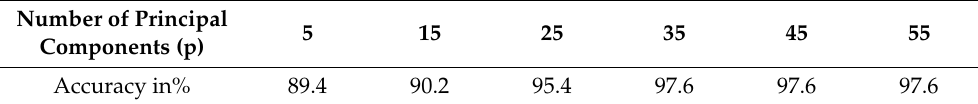
Table A1. Accuracy obtained using number of eigen vectors as d = 3 and different number of principal components (p).